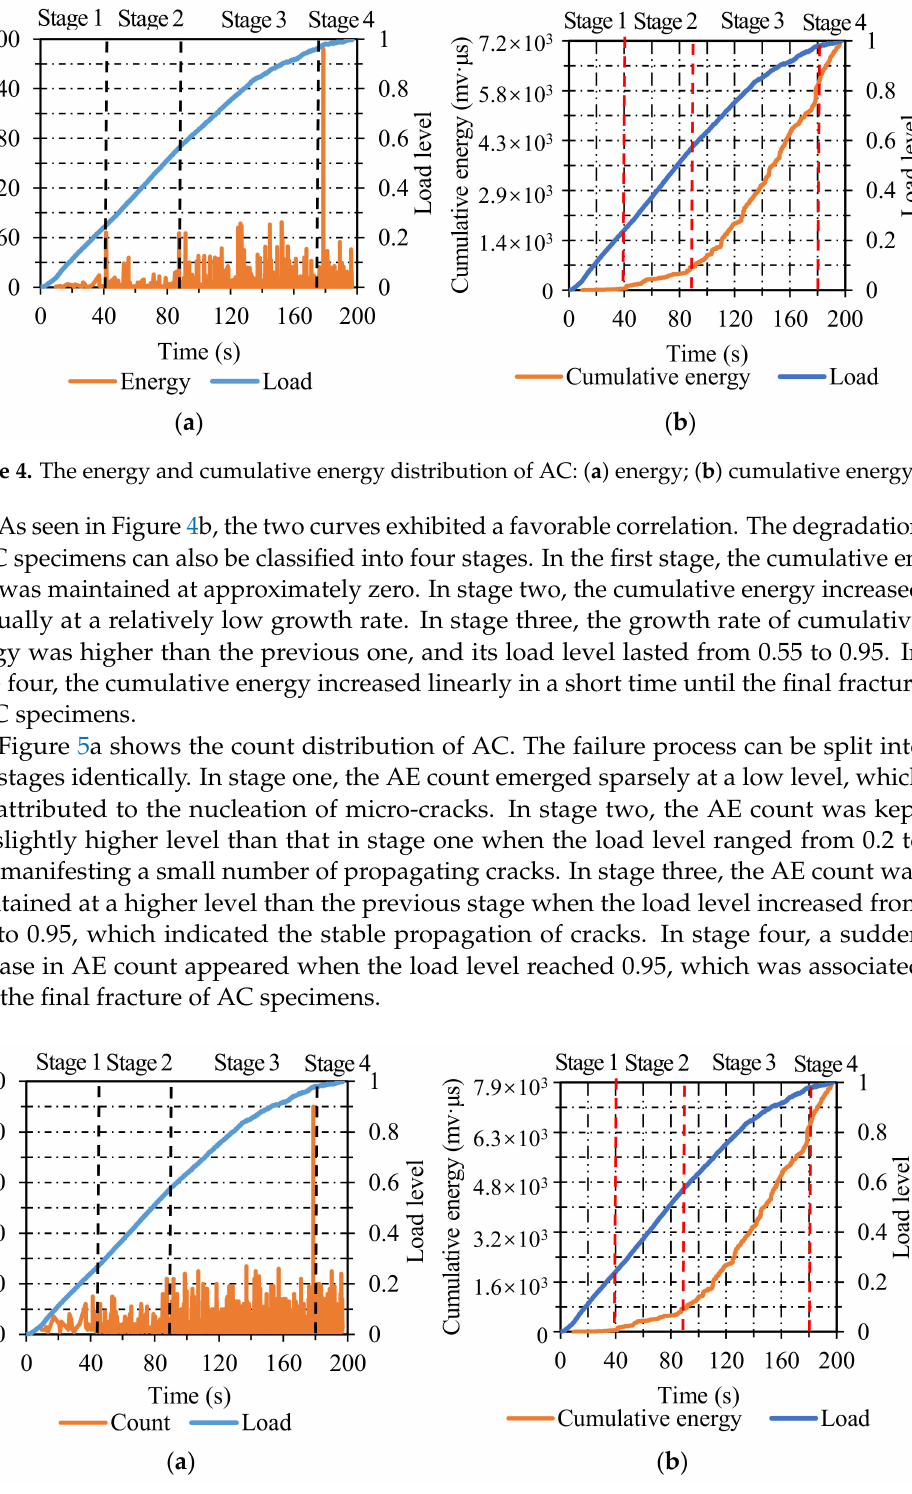
Figure 5. The count and cumulative count distribution of AC: ( a ) count; ( b ) cumulative